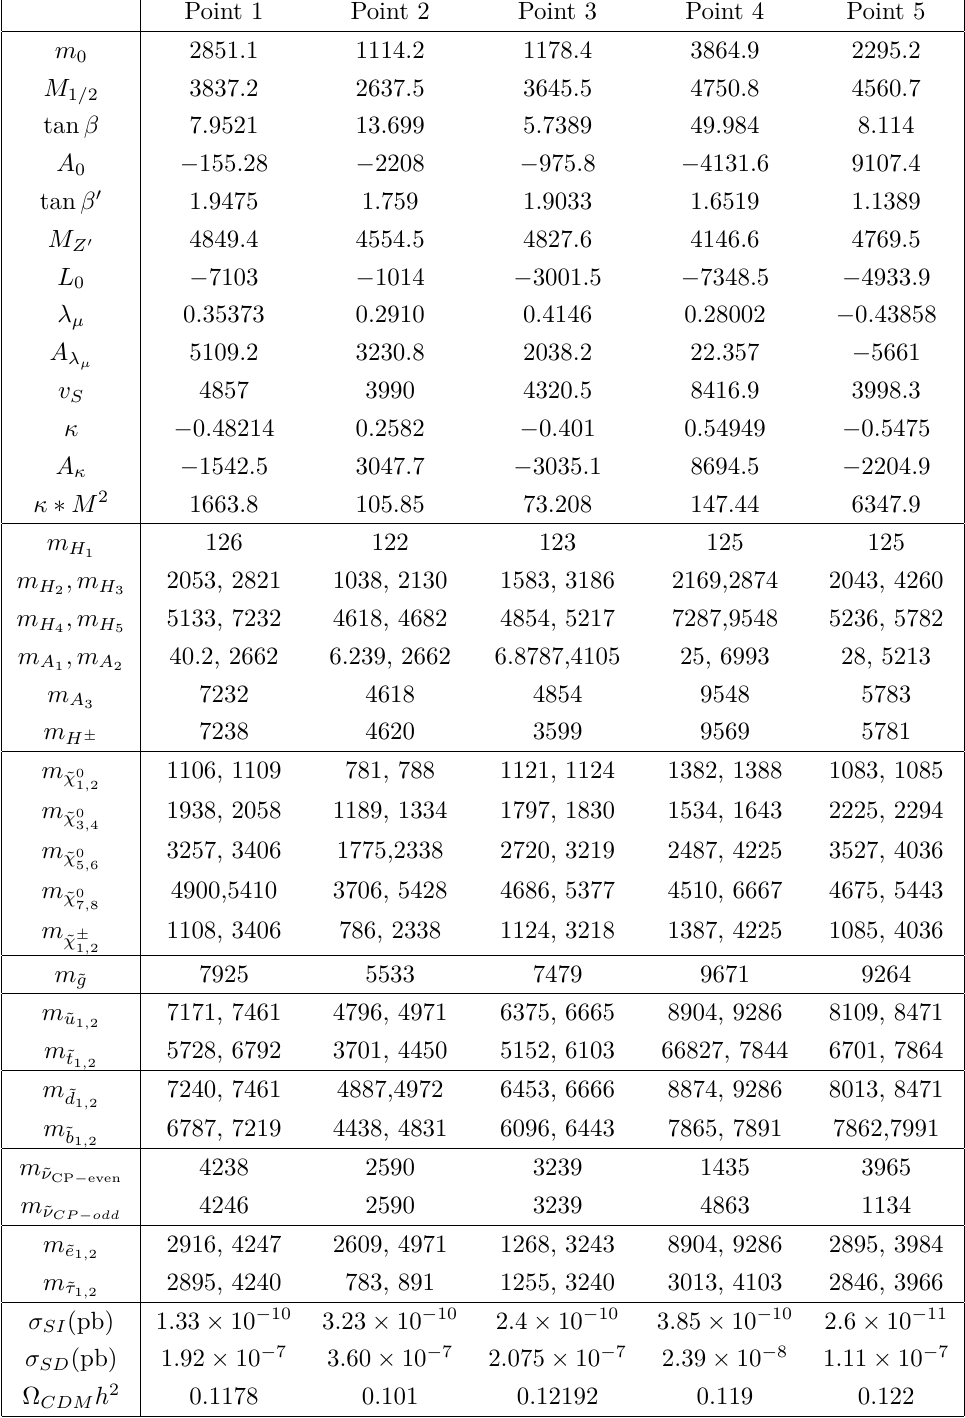
Table 2 . Masses are in units of GeV, µ > 0 and all points satisfy the sparticle mass bounds, and B-physics constraints described in section 3. Points 1 and 2 represent chargino-neutralino coannihilation and stau NLSP respectively. Point 3 corresponds to selectron NLSP. Points 4 and 5 display examples of CP-even and CP-odd lightest sneutrinos